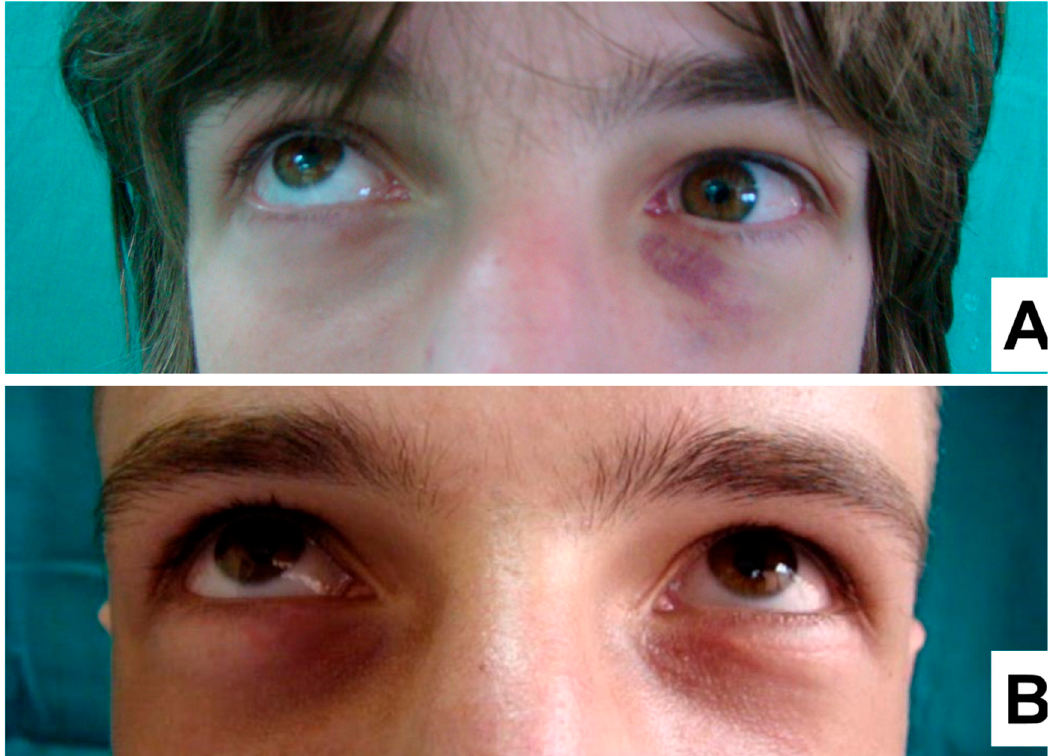
Figure 3. Pre- ( A ) and postoperative ( B ) situation of the eyelids in the patient undergoing orbital floor fracture treatment by a fully covered titanium mesh with collagen membrane. ( A ) Preoperative up-gaze restriction, as a result of the fracture of the left orbital floor. ( B ) Eye movements without any restrictions and symmetrical height of the eyelids without one sign of rigidity and cicatrization. Significantly improved extent of the eye movements and lack of lid retraction was